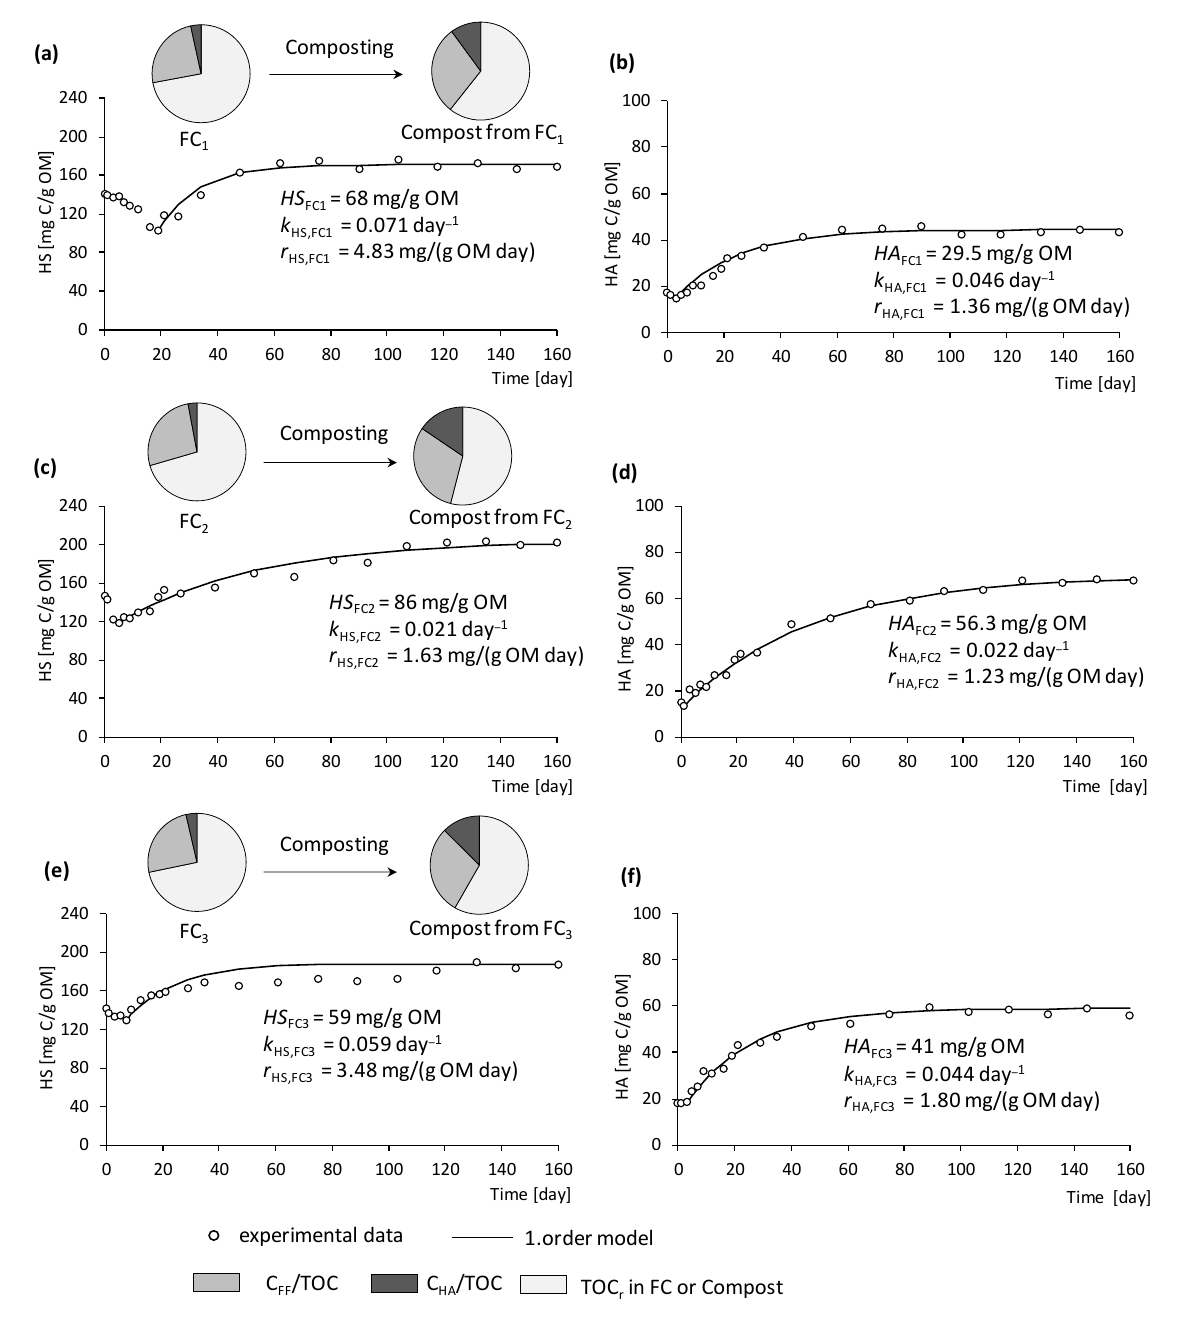
Figure 4. Changes in the concentration of HS ( a , c , e ), HA ( b , d , f ) during composting (until the 21st day in the bioreactor, and then in the windrow); kinetic parameters are given, in terms of the maximal increase in the concentration of HS (C max,HS ), HA ( Cmax,HA ), the rate constant of HS (k HS ) and HA (k HA ) formation, and the rate of HS (r HS ) and HA (r HA ) formation; in the form of a circle, the share of carbon (C) in FF in the total organic carbon (TOC) of the feedstock or compost (C FF /TOC, %), the share of C in HA in the TOC of the feedstock or compost (C HA /TOC,%), and TOC r (the remainder of the total organic carbon in the feedstock or compost) are presented.